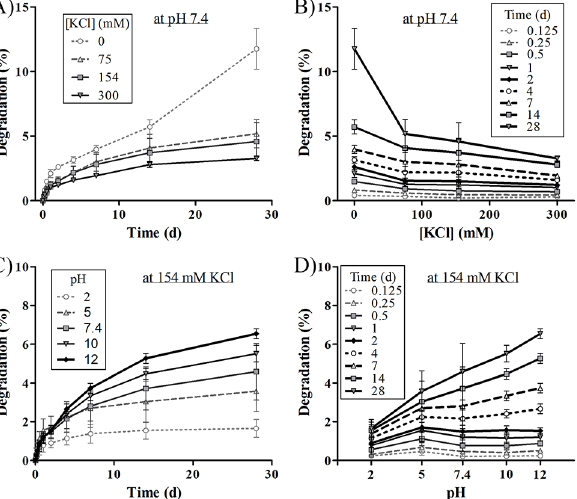
Fig 7. KTN bulk release. KTN gel bulk degradation in vitro at A-B) constant pH = 7.4, and C-D) constant [KCl] = 154 mM for over a period of 28 days at 37°C. Faster degradation occurred at longer time points, lower [KCl], and higher pH